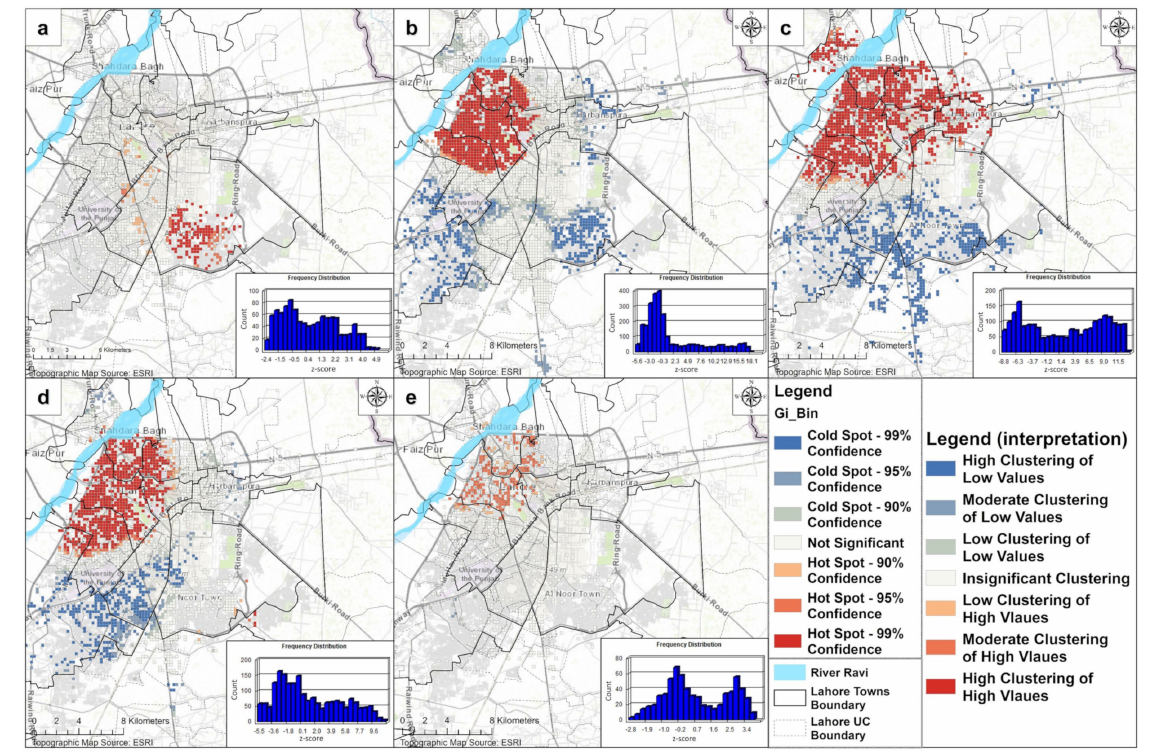
Figure 8. The Optimized Hot Spot Analysis showing dengue’s monthly (2007–2016) statistically significant hot spots and cold spots: ( a ) August, ( b ) September, ( c ) October, ( d ) November, ( e )